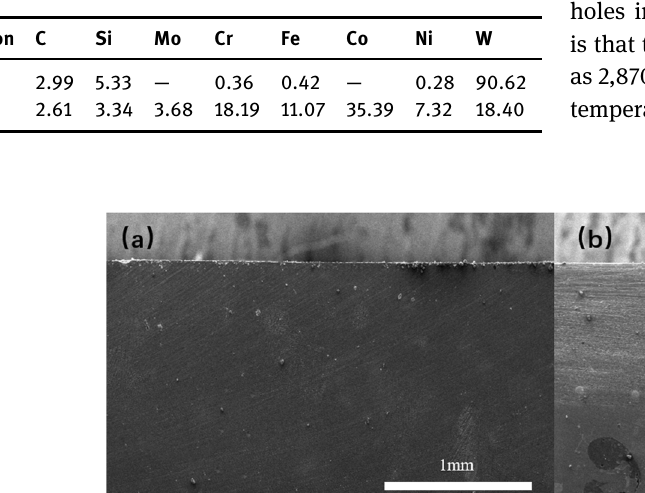
Table 3: Chemical compositions of the marked regions of Co + 60% WC sample ( % )